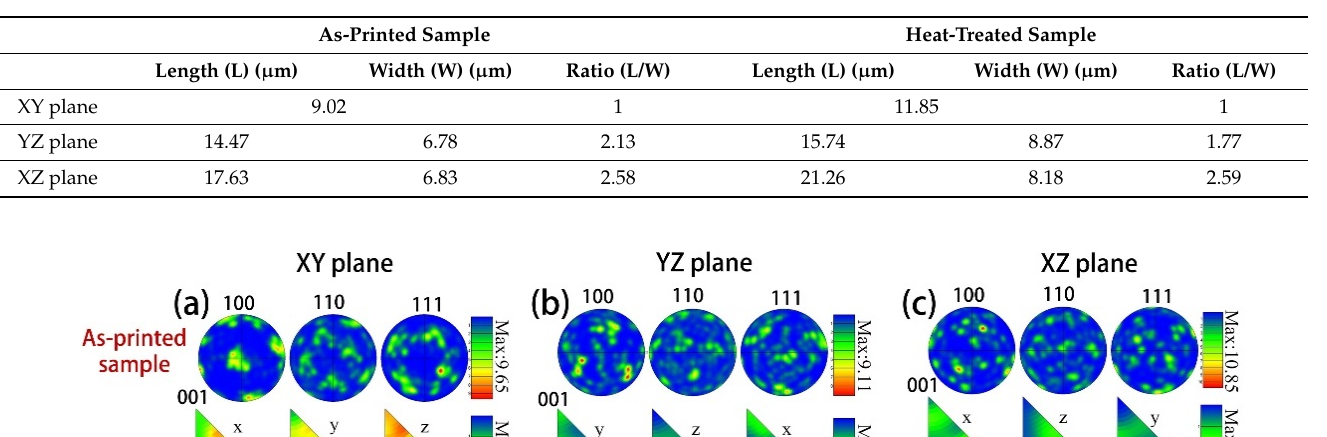
Figure 3. The OM and EBSD microstructures for different planes of the heat-treated nickel-based superalloy specimen: ( a ) OM and ( b ) EBSD of XY plane, ( c ) OM and ( d ) EBSD of YZ plane, and ( e ) OM and ( f ) EBSD of XZ plane. Table 3. The statistical results of grain size in the as-printed and heat-treated nickel-based superalloy, based on EBSD observations (Unit: µ m).